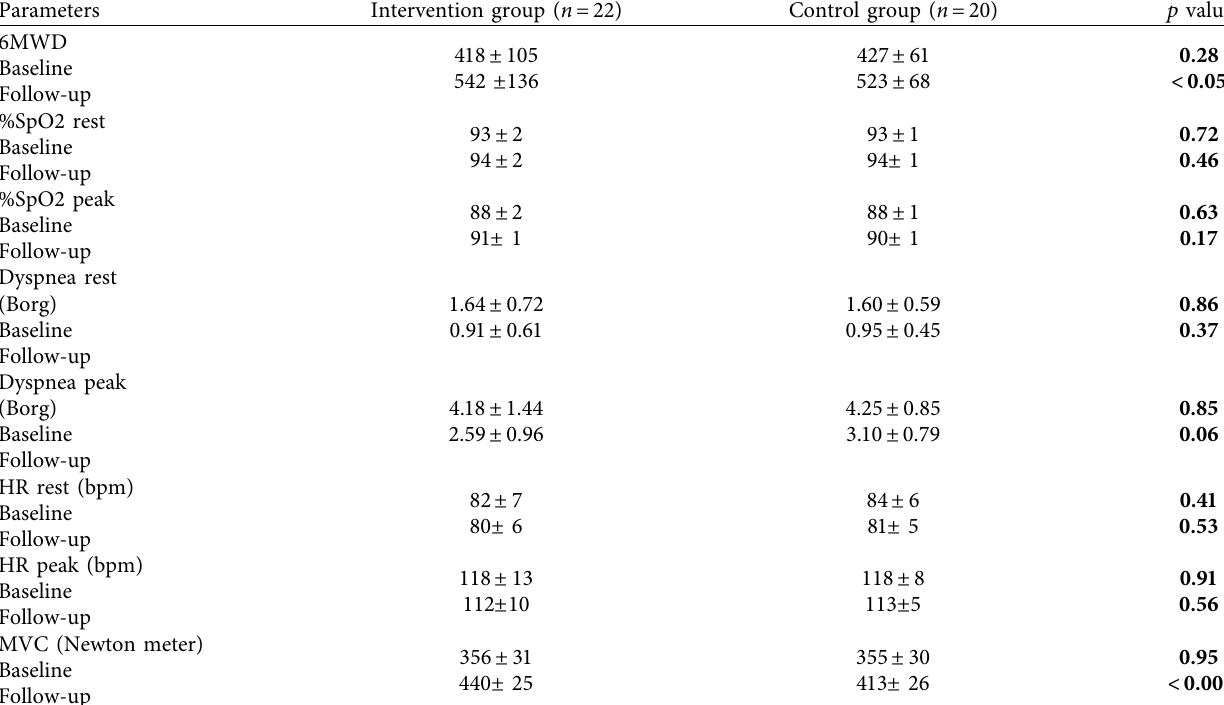
Table 4: 6MWT parameters and maximal voluntary contraction before and after the intervention.